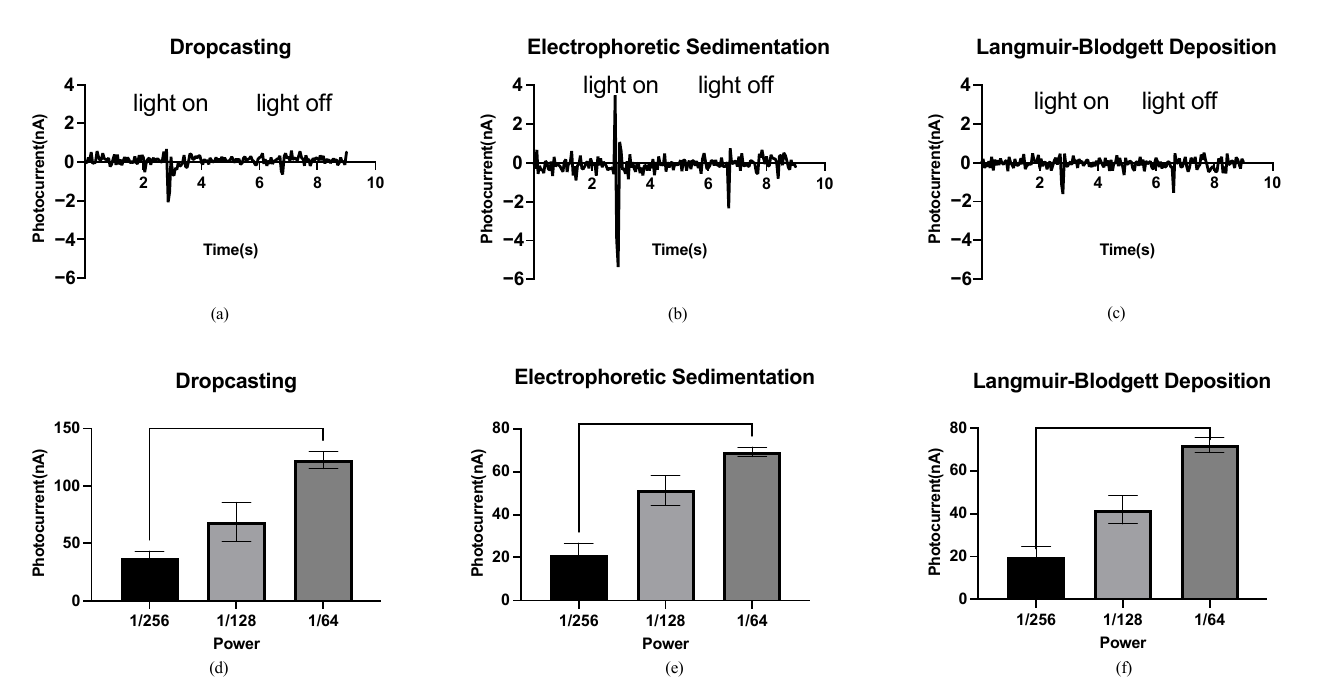
Figure 3. Photocurrent response of the bR films. ( a ) Photocurrent response of the bR film immobilized using the DC technique with a peak photocurrent of 2.07 nA. ( b ) Photocurrent response of the bR film immobilized using the EPS technique with a peak photocurrent of 5.38 nA. ( c ) Photocurrent response of the bR film immobilized using the LBD technique with a peak photocurrent of 1.61 nA. ( d – f ) Relationship between the power of the photoflash and peak photocurrent generated by the bacteriorhodopsin films immobilized with different techniques. One ‐ way ANOVA analysis shows that the peak photocurrent increases as the power of the light source increases.